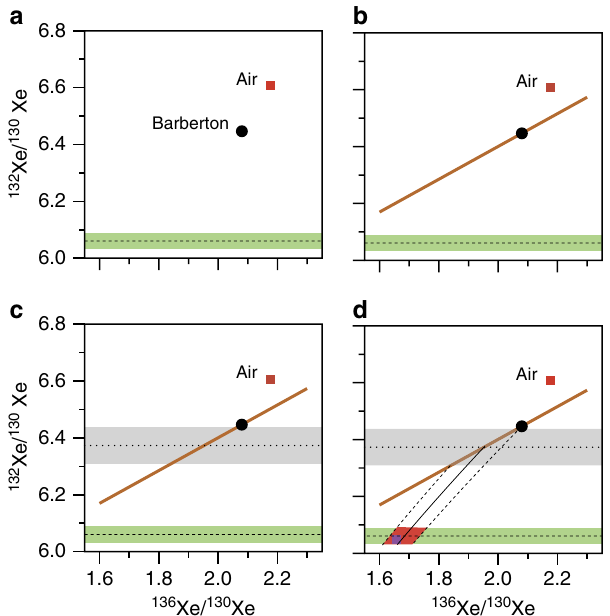
Figure 7 | Schematic view of the successive steps leading to the determination of the initial 136 Xe/ 130 Xe for the ancient atmosphere trapped in Barberton quartz. ( a ) The starting point uses only one data, the isotopic composition of Xe in Barberton quartz (the isotopic composition of the atmosphere is shown only for comparison) and makes the assumption that the starting 132 Xe/ 130 Xe is identical to SW-Xe (dashed line with the green range corresponding to the 2 s error of SW-Xe, ref. 33). ( b ) The orange line depicts the production of 132 Xe and 136 Xe by the spontaneous fission of 238 U. Barberton quartz samples exhibit these excesses and must, therefore, lie on this line. ( c ) The dotted line and the grey range represents the initial 132 Xe/ 130 Xe for Xe in Barberton quartz before addition of fission products. It was obtained by applying the mass fractionation recorded on stable isotopes 126 Xe and 128 Xe. ( d ) The intersection of the black line and the green range is used to estimate the primordial 136 Xe/ 130 Xe ratio for the Earth’s atmosphere before the progressive mass-dependent isotopic fractionation occurred as recorded in Barberton quartz. The resulting space of possibilities (range at 2 s ) appears in pink. The purple square corresponds to the isotopic composition of U-Xe (ref. 13).